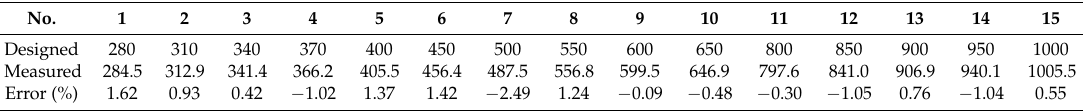
Table 4. The comparison between the designed and measured diameters (unit: μ m).